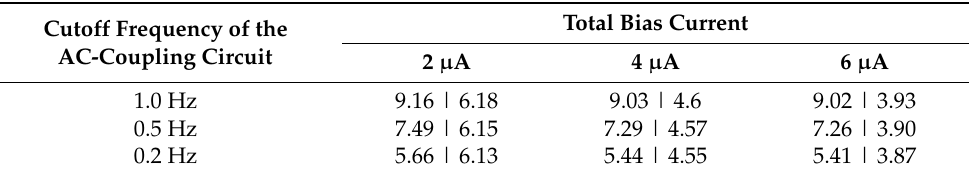
Figure 13. Output n oise PSD for pseudoresistors and operational amplifier. Figure 13. Output noise PSD for pseudoresistors and operational amplifier. Table 2. Equivalent input noise [μV rms ]. For each bias current and cutoff frequency the noise is Table 2. Equivalent input noise [ µ V rms ]. For each bias current and cutoff frequency the noise is shown for two frequency ranges: 1–300 Hz and 300 Hz–10 kHz. shown for two frequency ranges: 1–300 Hz and 300 Hz–10